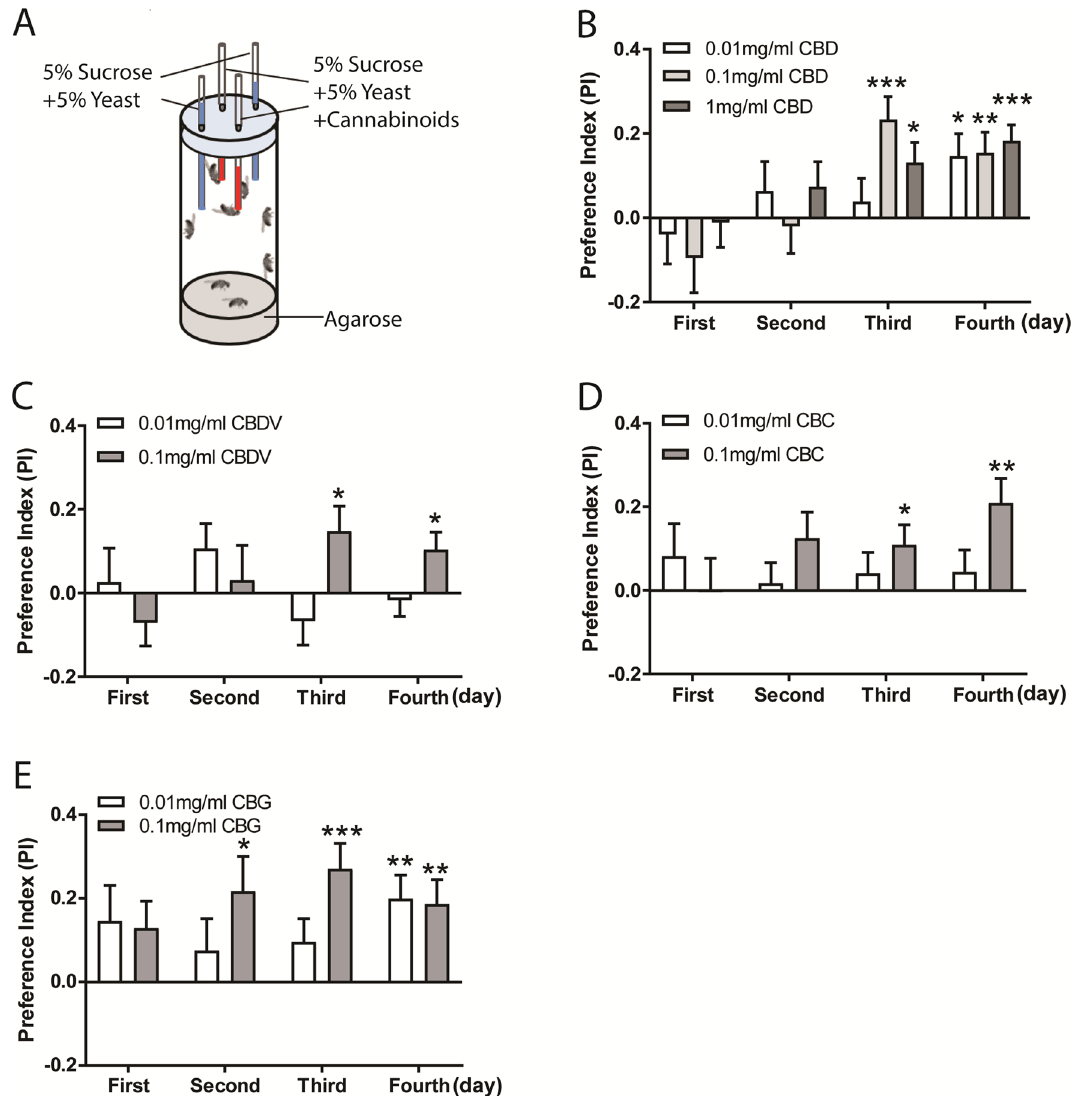
Figure 1. Flies developed a preference for phytocannabinoids. ( A ) Schematic diagram of the CAFE assay for examining cannabinoid preference. Eight flies in a single vial were presented with four capillaries in which two contained cannabinoids and the other two with normal liquid food for four consecutive days. ( B–E ) Flies exhibited and developed preference for phytocannabinoids in a time-dependent manner. ( B ) Delayed preference for 0.1 mg/ml and 1 mg/ml CBD was detected on day 3 and day 4. A significant increase in preference for food containing 0.01 mg/ml CBD was observed on day 4. Flies displayed preference for food containing 0.1 mg/ml CBDV ( C ) and CBC ( D ) on day 3 and day 4. Similar to CBD, the preference for CBG-containing liquid food was significantly increased from day 2 to day 4 (n = 17–28 vials/group). Data are represented as mean ±